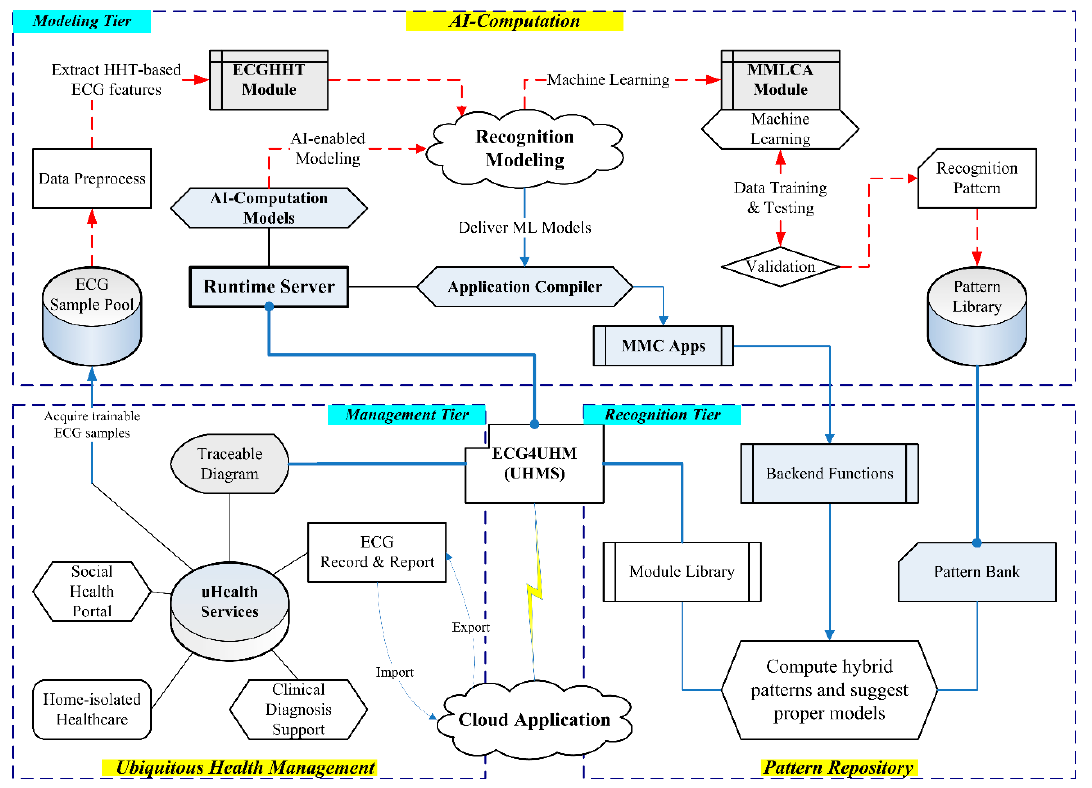
Figure 4. The three-tier UHMS infrastructure for the self-developed ECG4UHM platform with AI